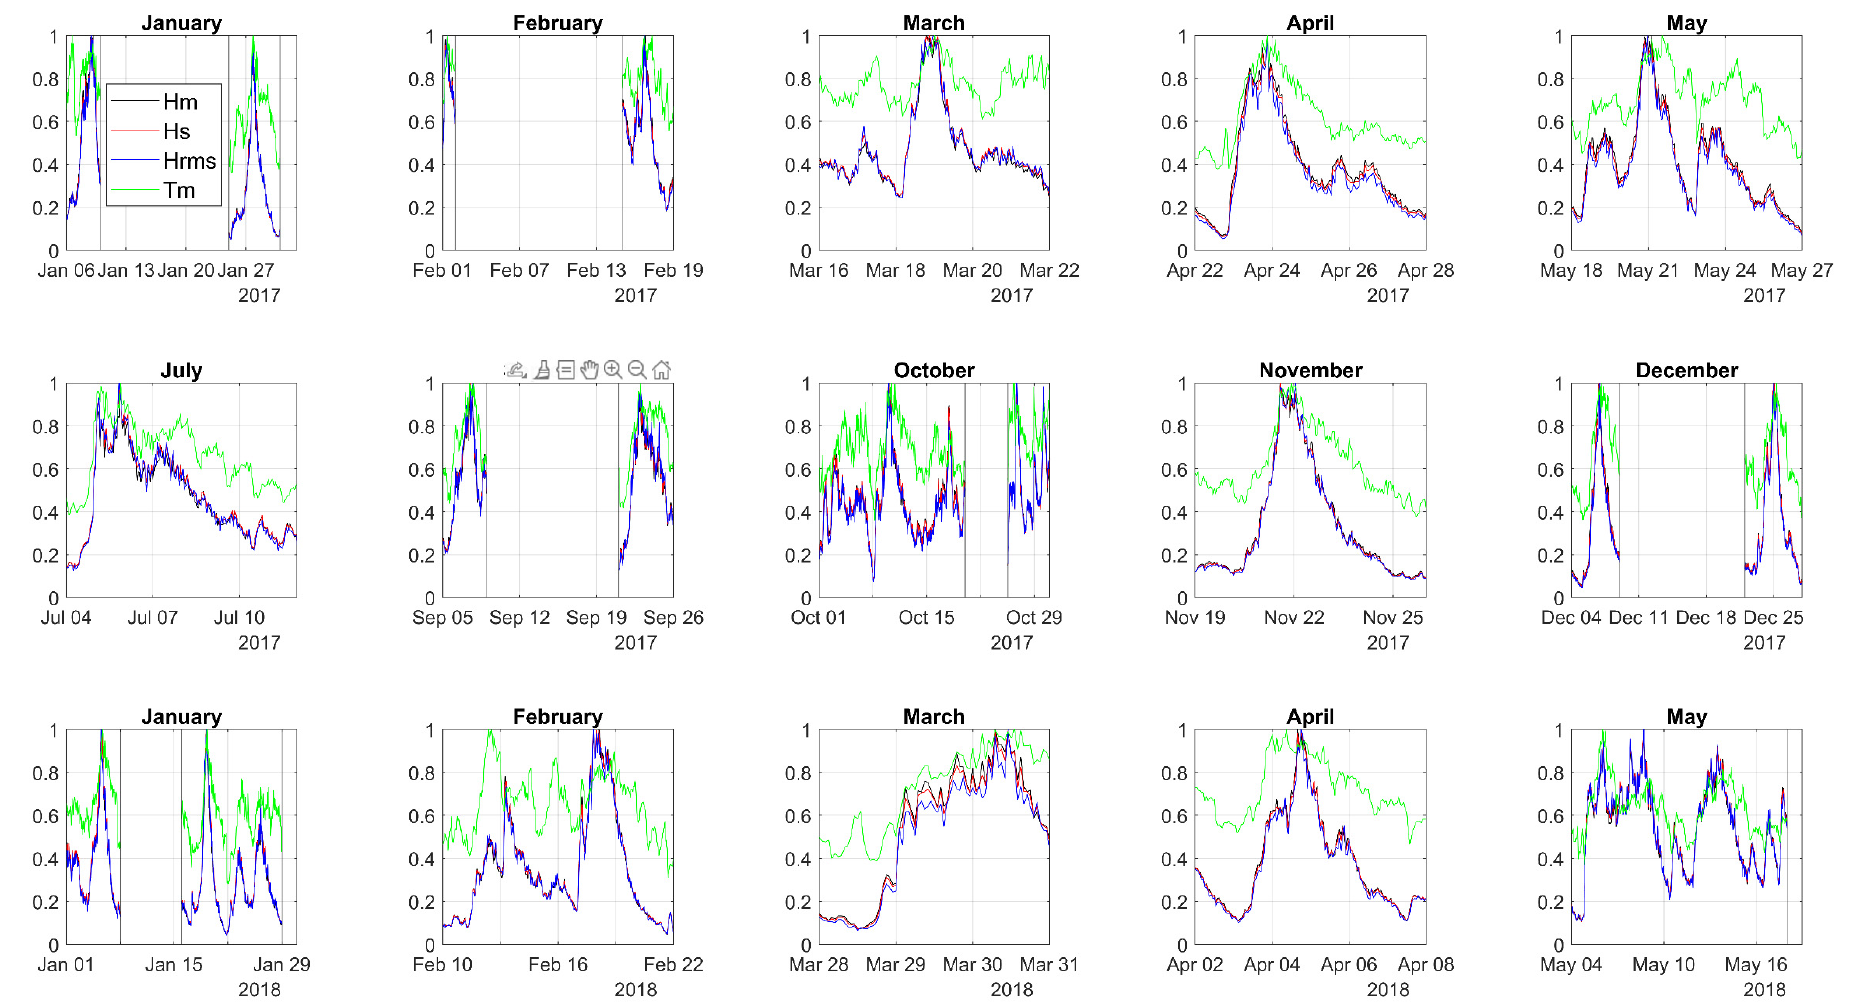
Figure 4. Normalized wave parameters during 20 high sea events. T m (green), H m (black), H rms (blue), and H s